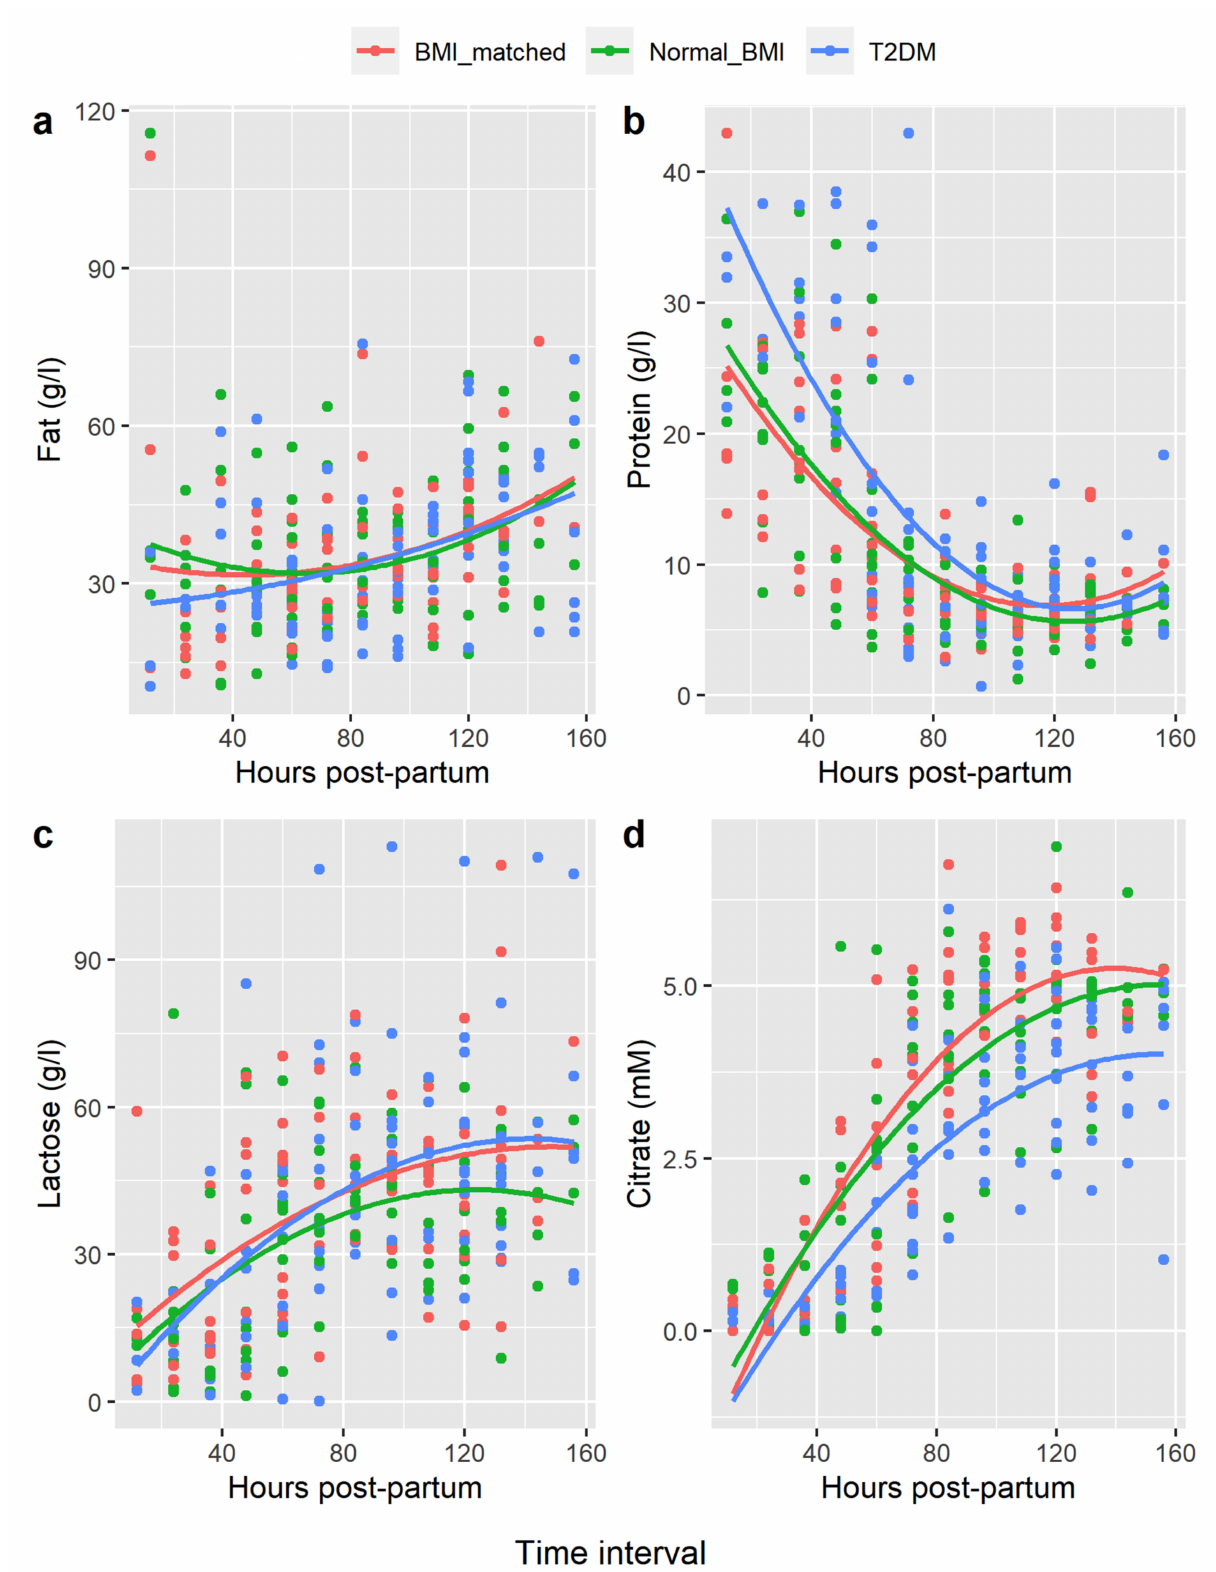
Figure 1. Polynomial Regression of Breastmilk Constituents Hours Postpartum. Legend: ( a ) = fat, ( b ) = protein, ( c ) = lactose, ( d ) = citrate. x -axis = hours postpartum, mean values for each woman compared at 12 hourly intervals. y -axis = concentration breastmilk constituent in gram/litre (g/L) or millimolar